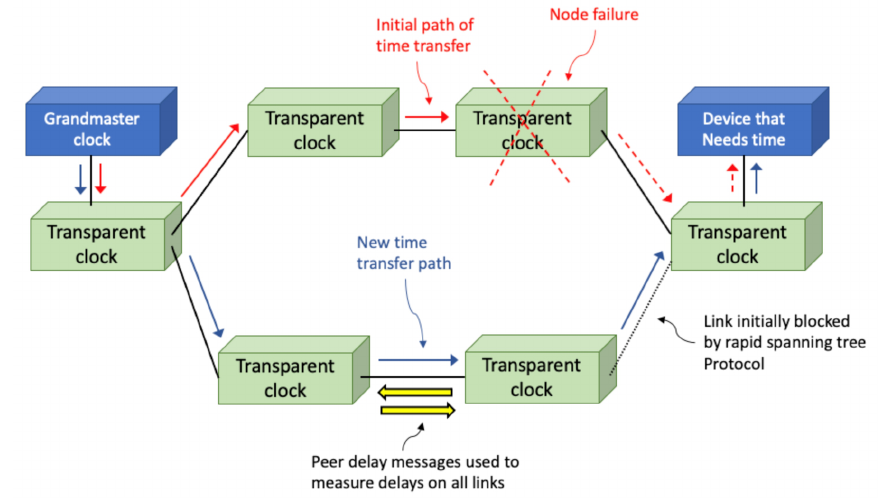
Figure 4. A timing path change in a PTP network when a switch